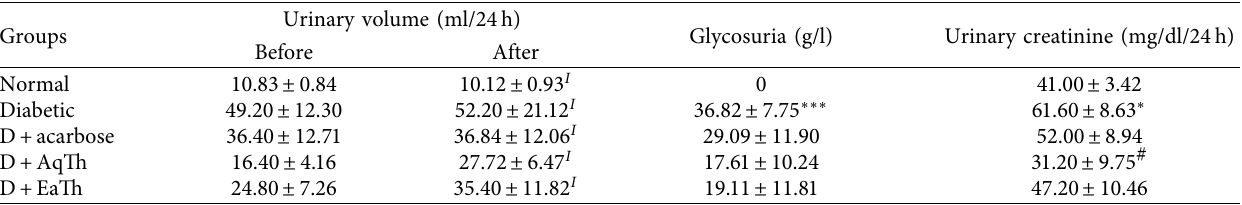
Table 2: Effect of 200mg/kg AqTh, 50 mg/kg EaTh, and 10mg/kg acarbose on urinary parameters in STZ-induced diabetic rats after 4 weeks treatment. Groups